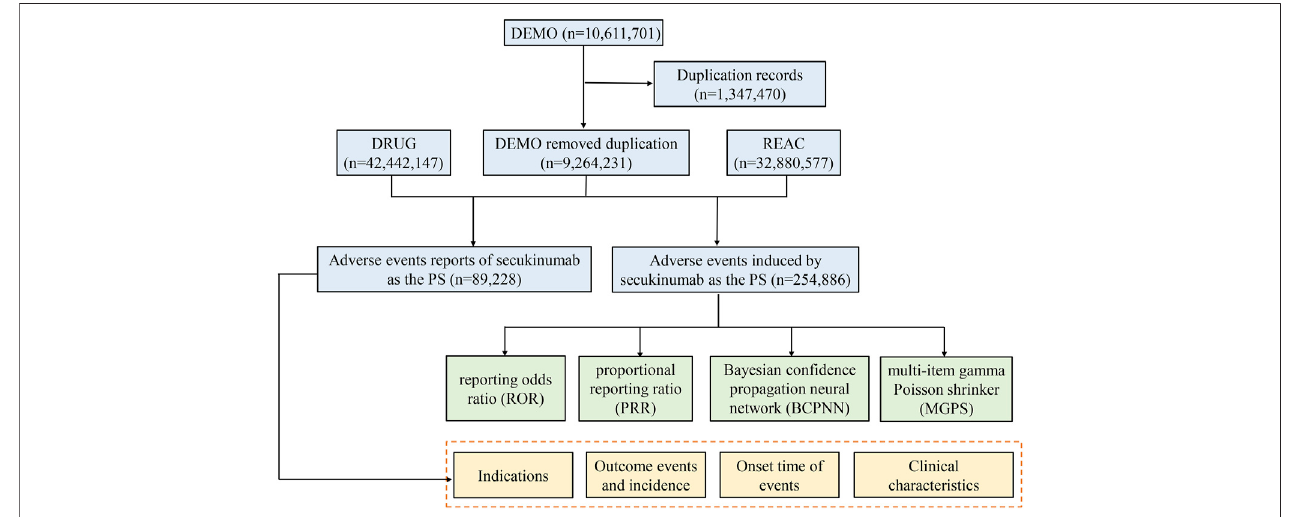
FIGURE 1 | The process of selecting secukinumab-associated adverse events from Food and Drug Administration adverse event reporting database.